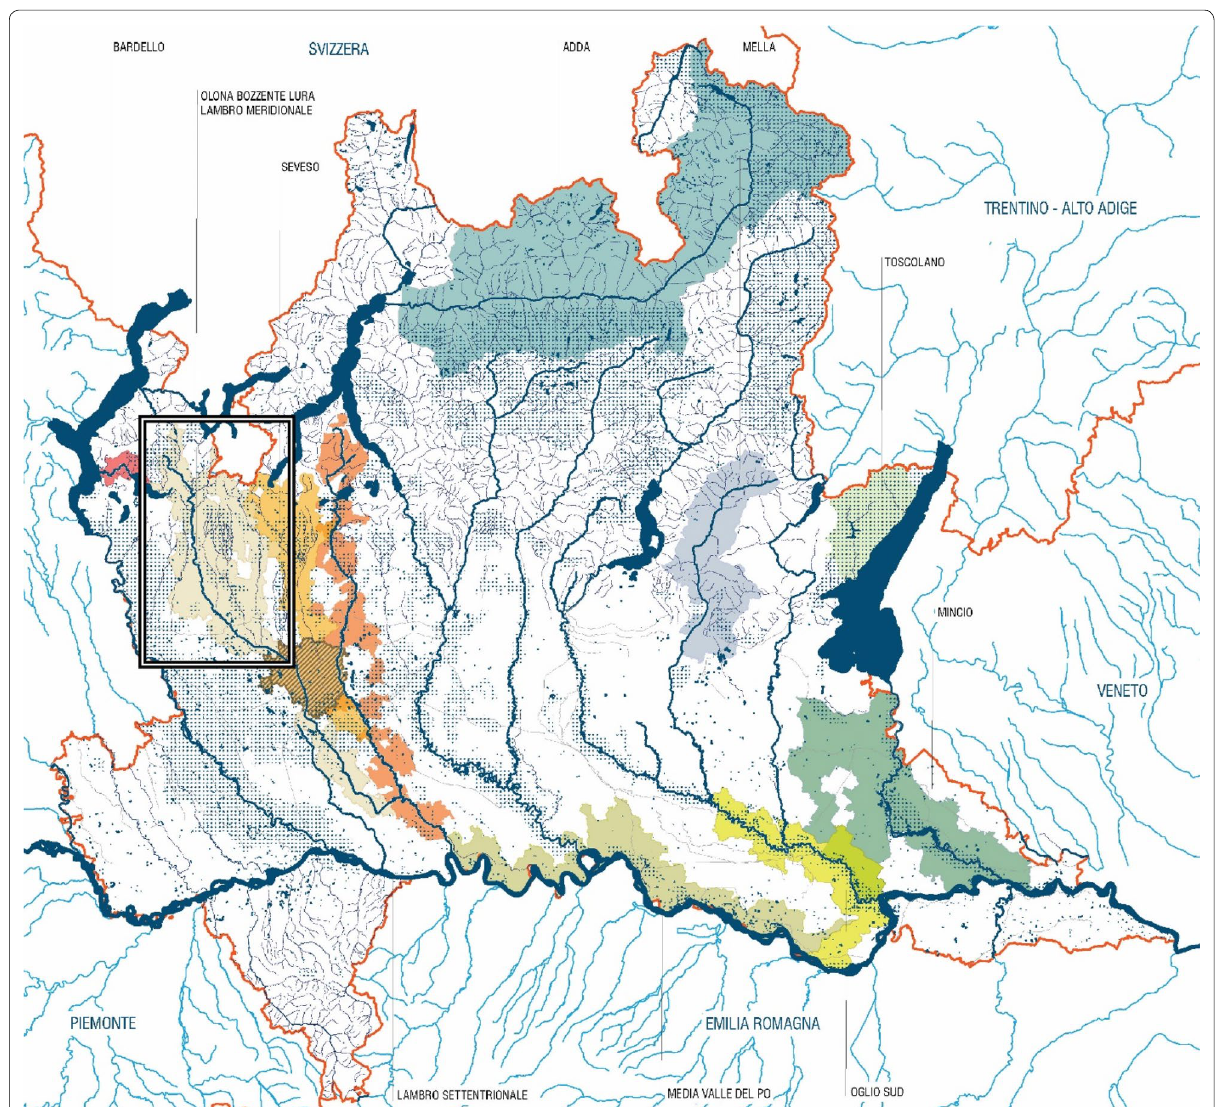
Fig. 3 The River Contracts geography in the regional context and the Olona-Bozzente-Lura River Contract (in the box) (Source ERSAF